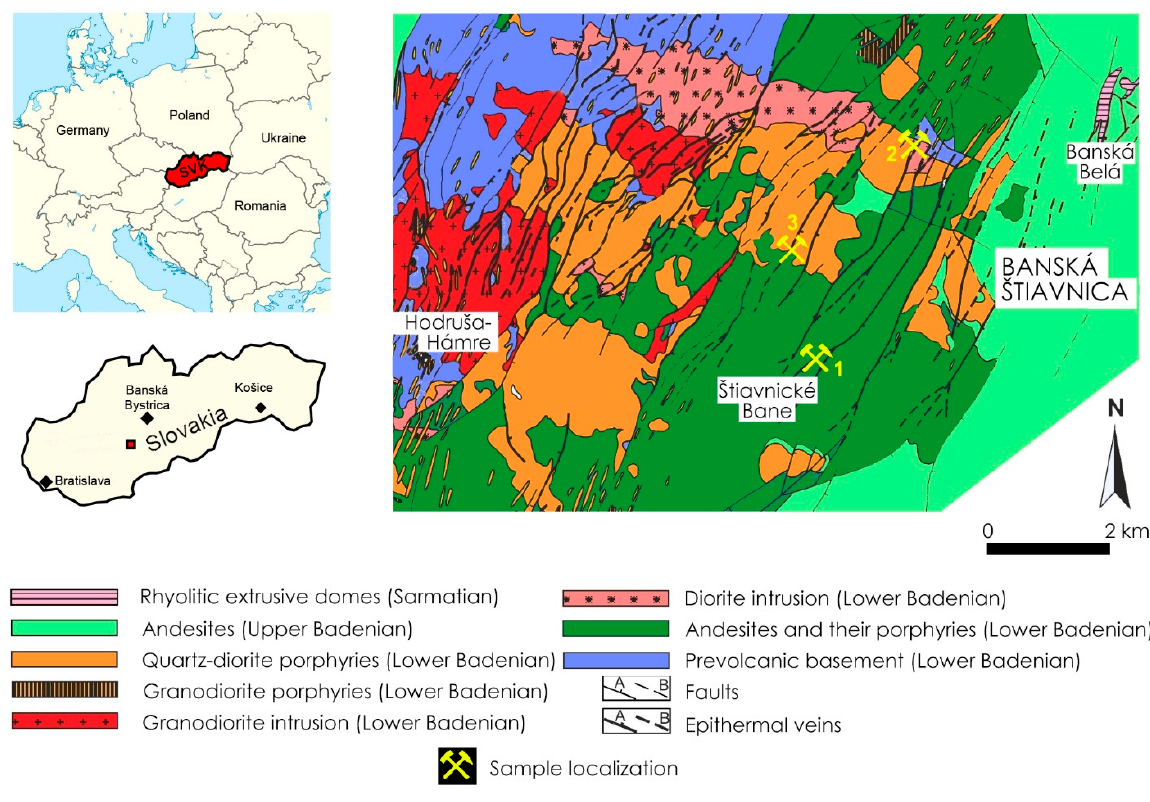
Figure 1. Geological sketch map of the Banská Štiavnica area (adapted, based on [31]) with sample localization: 1—Göllner adit, 2—Michal shaft, 3—Rozália mine. localization: 1—Göllner adit, 2—Michal shaft, 3—Roz á lia